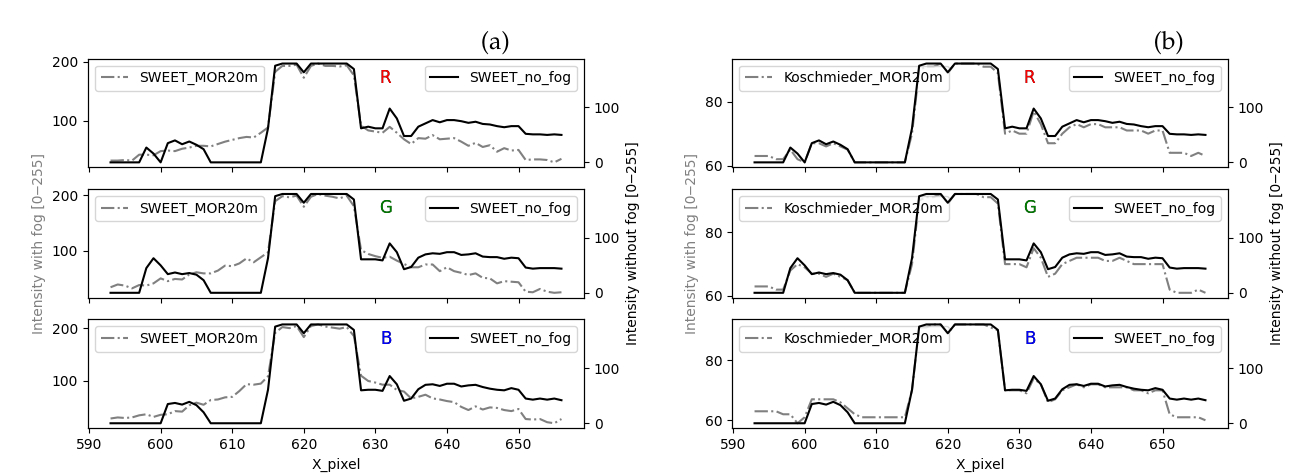
Figure 17. Comparing the intensity of a pixel line for the urban scene simulated by the SWEET simulator ( a ) and Koschmieder ( b ), rescaled